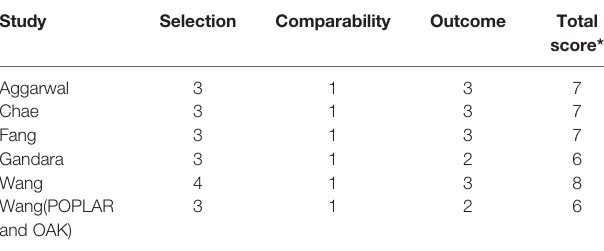
TABLE 2 | The Newcastle – Ottawa Scale (NOS) assessment of the included studies ’ risk of